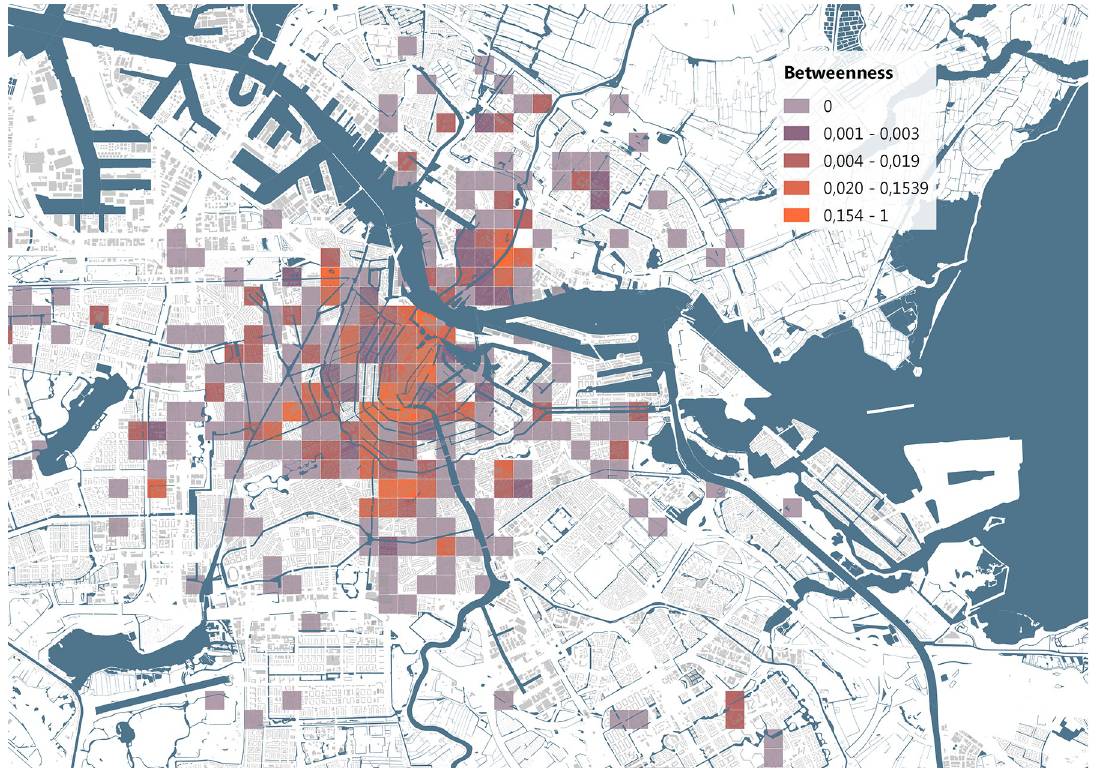
Fig 15. Betweenness, and therefore importance for the movements of stolen bikes, of the grid cells. Base map data from